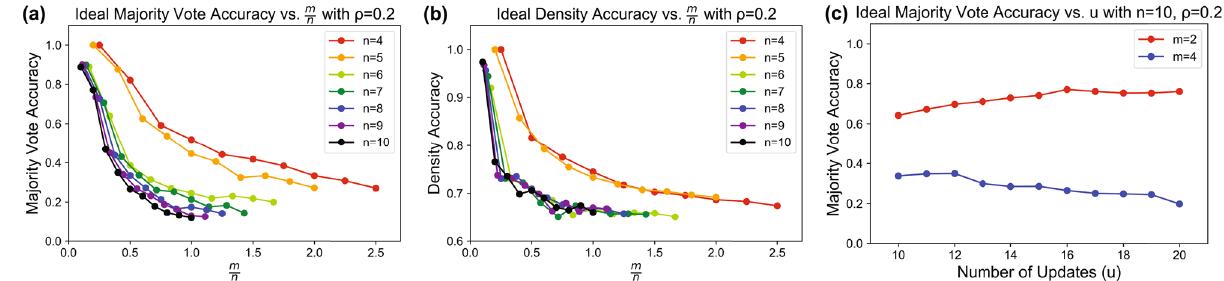
Figure 7. Effective QHAM Capacity. ( a ) Majority vote accuracy measurements for the QHAM for memories 4, 5, . . . , 10 1, 2, . . . , 10 m / n . ( b ) Density accuracy measurements from of length n and m versus α = ∈ { } ∈ { } the same test conditions as ( a ) versus m / n . ( c ) Demonstration of hyperparameter tuning for u . In this case, the 2 and 12 for m 4 optimal u based on majority vote accuracy is 16 for m = =